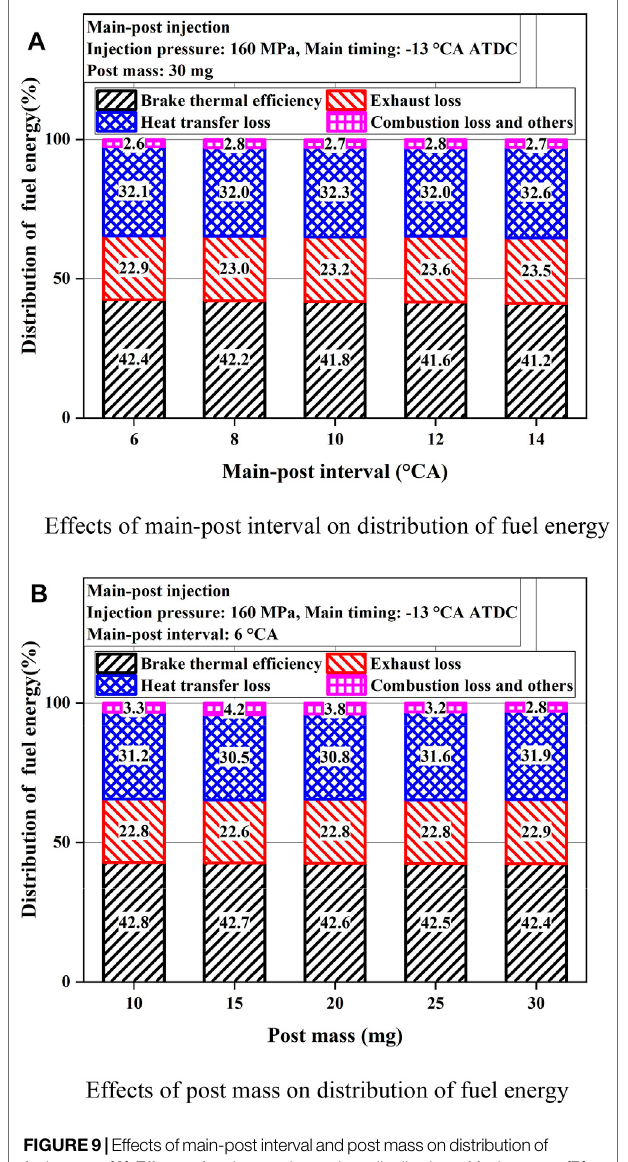
FIGURE 10 | Effects of main-post interval and post mass on emissions. (A) Effects of main-post interval on emissions, (B) Effects of post mass on